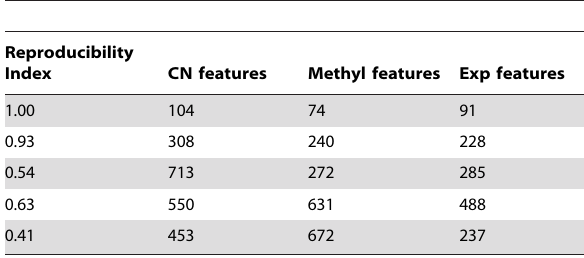
Table 2. Integrated subtype reproducibility and number of subtype-discriminant